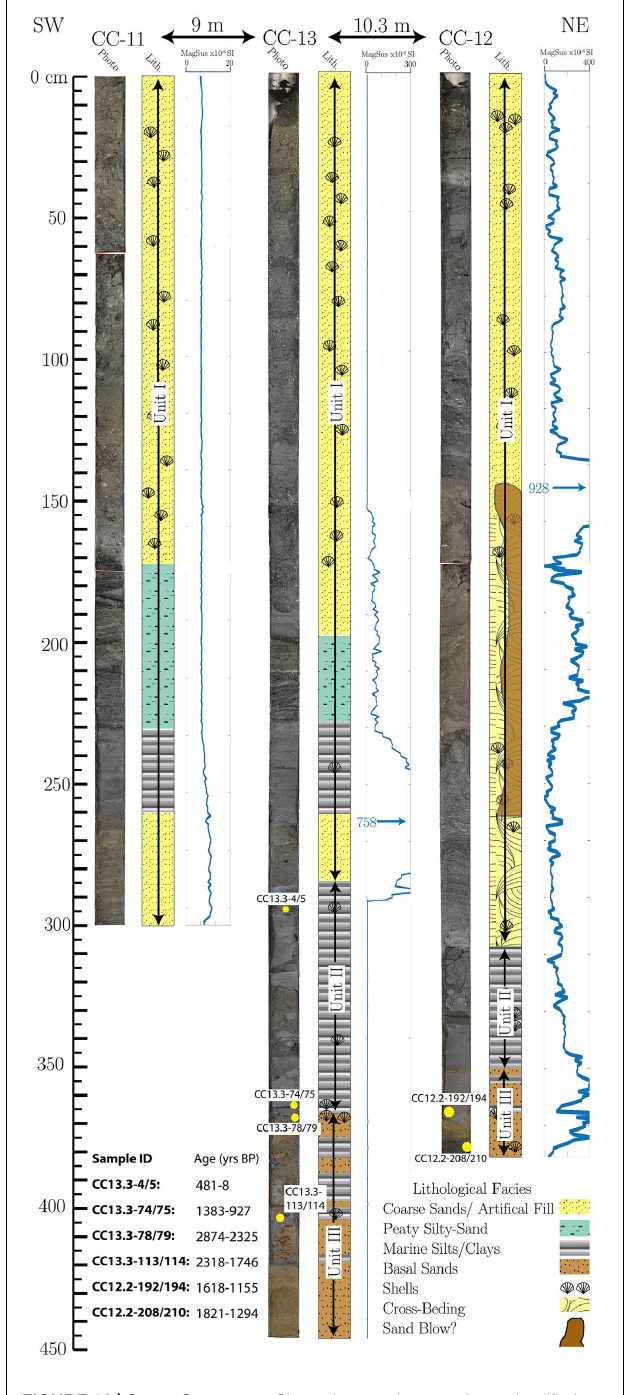
FIGURE 12 | Crown Cove cores. Shown is core photographs, a simplified lithology, and magnetic susceptibility (max value indicated when beyond scale). Yellow dots are sample locations for radiocarbon dating (yrs BP, years Before Present and is expressed as years before 1950 CE). Transition from post 1940s dredge surface and natural estuarine/marine deposit can be seen in cores CC-13 ( ∼ 285 cm) and CC-12 ( ∼ 305 cm) and mark the beginning of unit two. Oxidized sands (unit three) interpreted to represent subaerial exposure is observed at the bottom of cores CC-12 and CC-13. Location of cores is shown in Supplementary Figure 5a